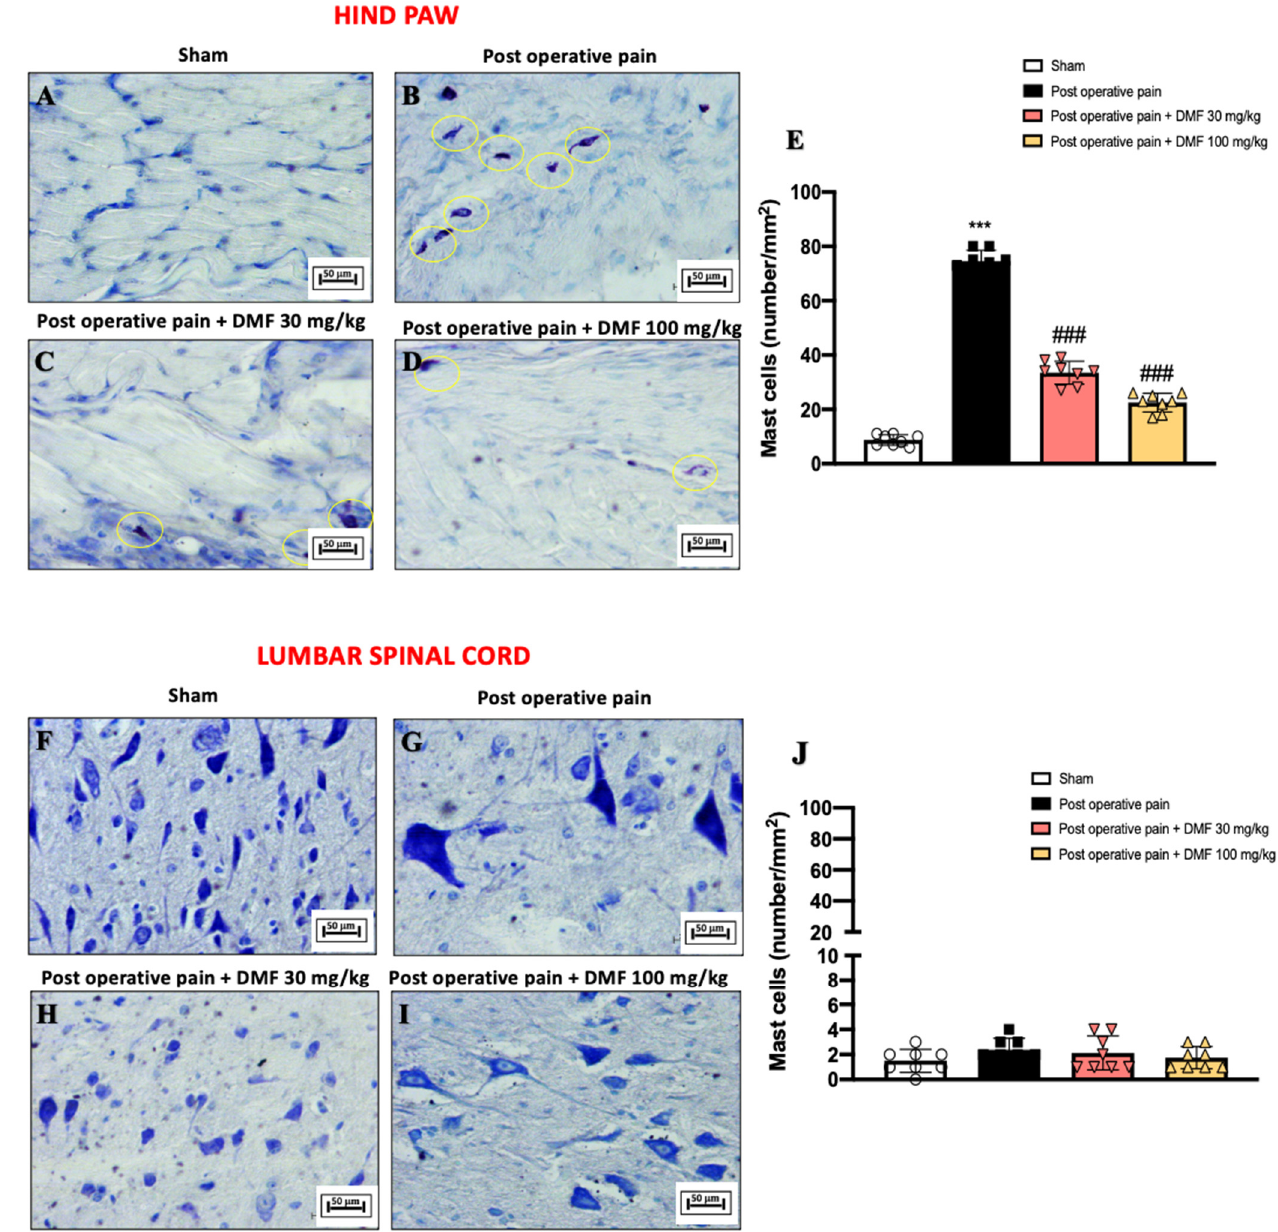
Figure 5. DMF treatment reduced mast cell degranulation following PO pain induction. Toluidine blue staining on hind paw tissue: sham ( A ), PO pain ( B ), DMF 30 mg/kg ( C ), DMF 100 mg/kg ( D ) and score ( E ). Toluidine blue staining on lumbar spinal cord tissue: sham ( F ), PO pain ( G ), DMF 30 mg/kg ( H ), DMF 100 mg/kg ( I ) and score ( J ). Magnification 20×. A p -value of less than 0.05 was considered significant; *** p < 0.001 vs. sham, ### p < 0.001 vs. PO pain.